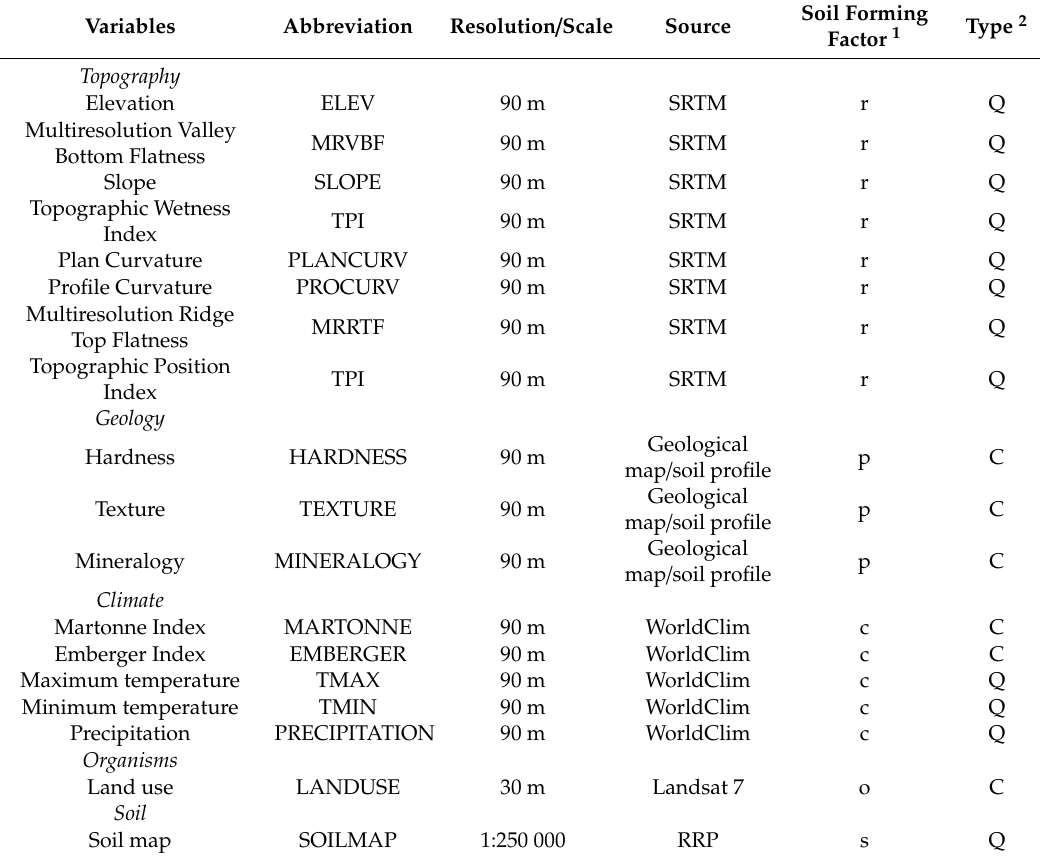
Table 2. Exhaustive categorical and continuous